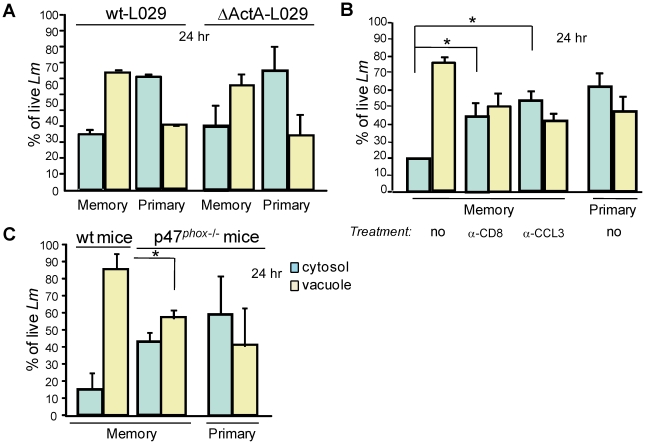
Cytosolic bacteria are engulfed and killed via ROI in the vacuoles of phagocytes during a protective secondary response.In (A), primary and immune mice (4–6/group) were challenged with 3×105 wt- or ΔActA- L029 Lm and spleens were harvested 24 hrs later and treated as described in figure 5. Histograms show the frequencies (mean +/− SE) of cytosolic (blue bars) and vacuolar (yellow bars) Lm CFUs in phagocytes in a pool of 2 experiments. In (B), primary and memory mice (9–12/group) were treated or not with anti-CD8 or anti-CCL3 before challenge with 3×105 wt-L029 Lm. Histograms indicate as in (A) in a pool of 3 experiments (n = 9). In (C), primary and memory p47phox
−/− and C57BL/6 wt control mice (5–6/group) were challenged with 3×105 wt-L029 Lm. Data indicate the number (mean +/− SE) of cytosolic and vacuolar Lm CFUs in phagocytes (n = 5).